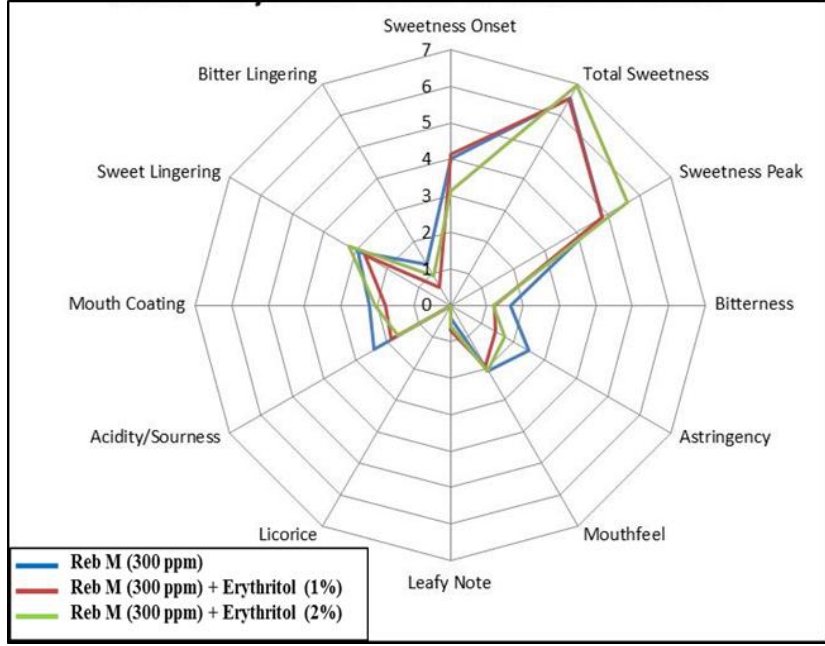
Figure 9. Sensory profile of di-blends of rebaudioside M ( 7 ) and erythritol in acidified